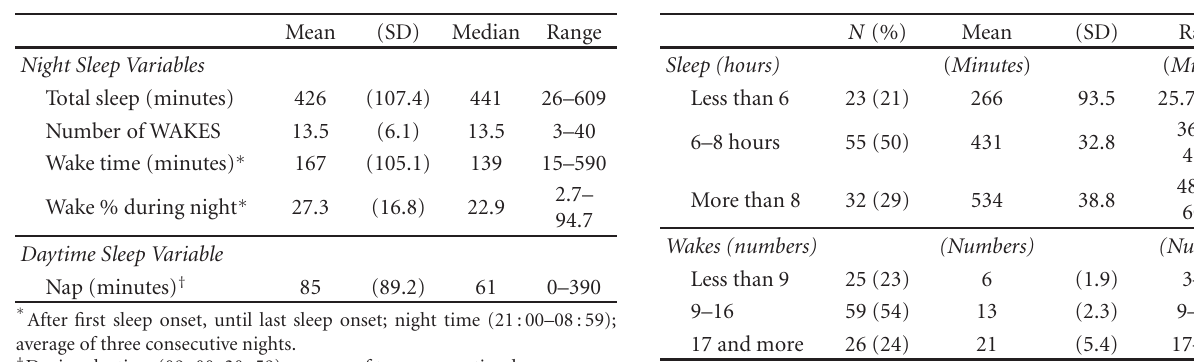
Table 2: Night and day characteristics ( N = 110). Table 3: Sleep, wakes, and naps in categories ( N =